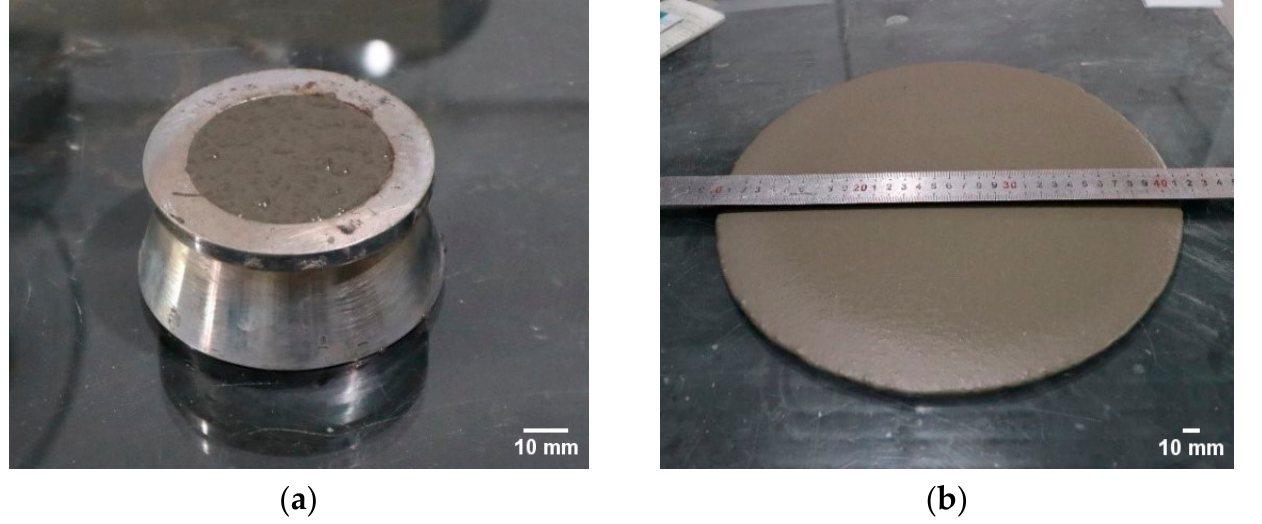
homogeneous material during the setting process. The increase in cement paste strength enhances the hardness of the concrete material. The present study used two types of silica fume: densified and undensified. The content of silica powder and slag was varied in the mixture to evaluate the effect on the strength of the cement paste. Table 5. Selected aggregate ratios. Content of Ingredients (%) Number Aggregate Agg-1 Agg-2 Agg-3 1 Quartz sand 30 40 18 2 Crushed stone-3 70 0 42 3 Crushed stone-5 0 60 40 The ratio of water to binder (W/B) is a necessary parameter in choosing the ingredients of the mixture. The ratio should be lower than the value of 0.25 to ensure a reasonable balance between the flow properties of the concrete and the strength of the hardened concrete [34]. The present study employed a W/B ratio (0.161). All samples of each group were checked for flow, as shown in Figure 4. After tapering, the mixture flowed evenly in all directions with a round shape. In addition, the surface of the cement paste did not show a stratification or water separation phenomenon. The samples were divided into three groups with the powder composition as follows: